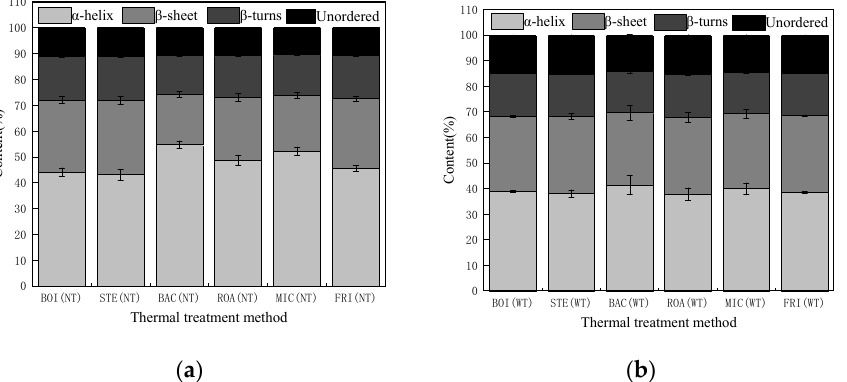
Figure 4. Effect of different thermal treatment methods and the addition of TGase on the protein conformation of D. maruadsi surimi products. ( a ): NT; ( b ): WT. BOI: boiled D. maruadsi surimi products; STE: steamed D. maruadsi surimi products; BAC: back-pressure sterilized D. maruadsi surimi products; ROA: roasted D. maruadsi surimi products; MIC: microwaved D. maruadsi surimi products; FRI: fried D. maruadsi surimi products; NT: group of without Tgase; WT: group of with Tgase.